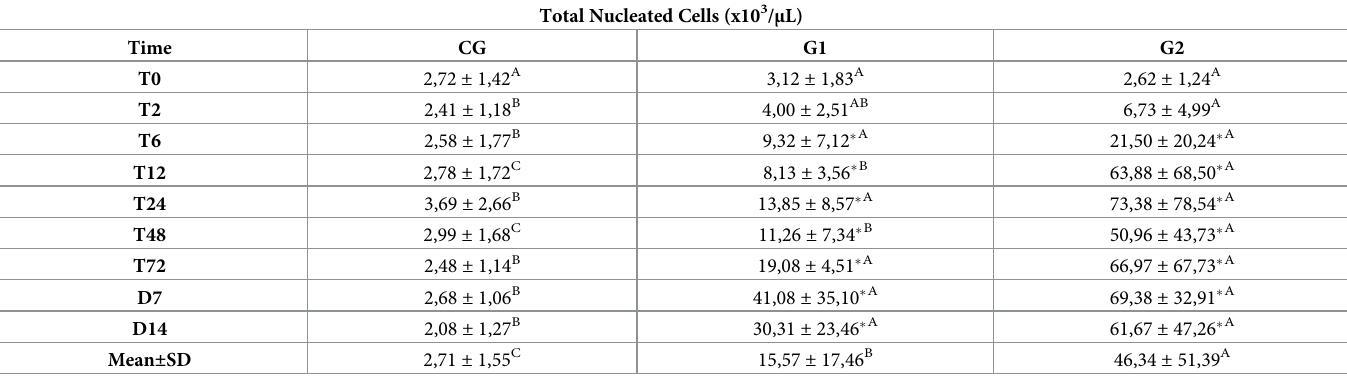
( � ) represent differences compared to baseline time (T0) within the group; Different capital letters represent differences between groups at the same time; p �